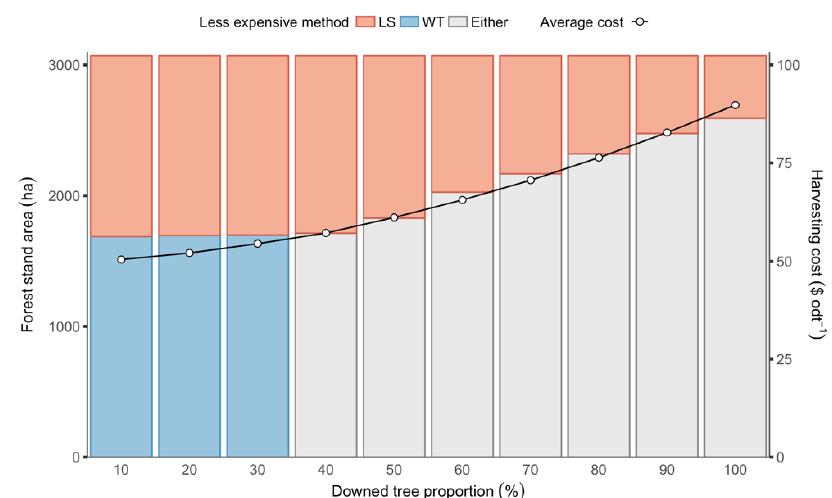
Figure 5. Effects of downed tree proportion on the average harvesting costs and the amount of forest stand areas allocated to the least costly harvesting method between lop and scatter (LS) and whole-tree harvesting (WT).